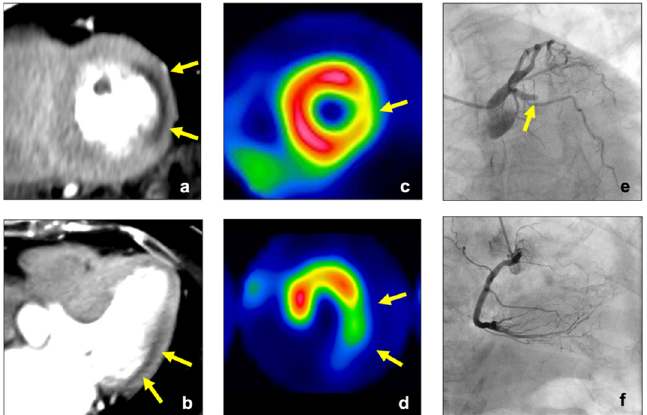
Figure 3. A 75-year-old woman with effort angina. Stress CTP image of the left ventricle showed a perfusion abnormality in the lateral wall (yellow arrow, ( a , b )), and MPR in this lesion was lower than the cut-off value of MPR in this study (0.60 < cut-off value: 0.81). SPECT (( c , d ), stress) showed a perfusion abnormality in the lateral wall (yellow arrow). ICA (( e ), LCA, ( f ), RCA) revealed chronic total occlusion within the LCX. CTP, computed tomography perfusion; MPR, myocardial perfusion ratio; SPECT, single-photon emission computed tomography; ICA, invasive coronary angiography; LCA, left coronary artery; RCA, right coronary artery; LCX, left circumflex coronary